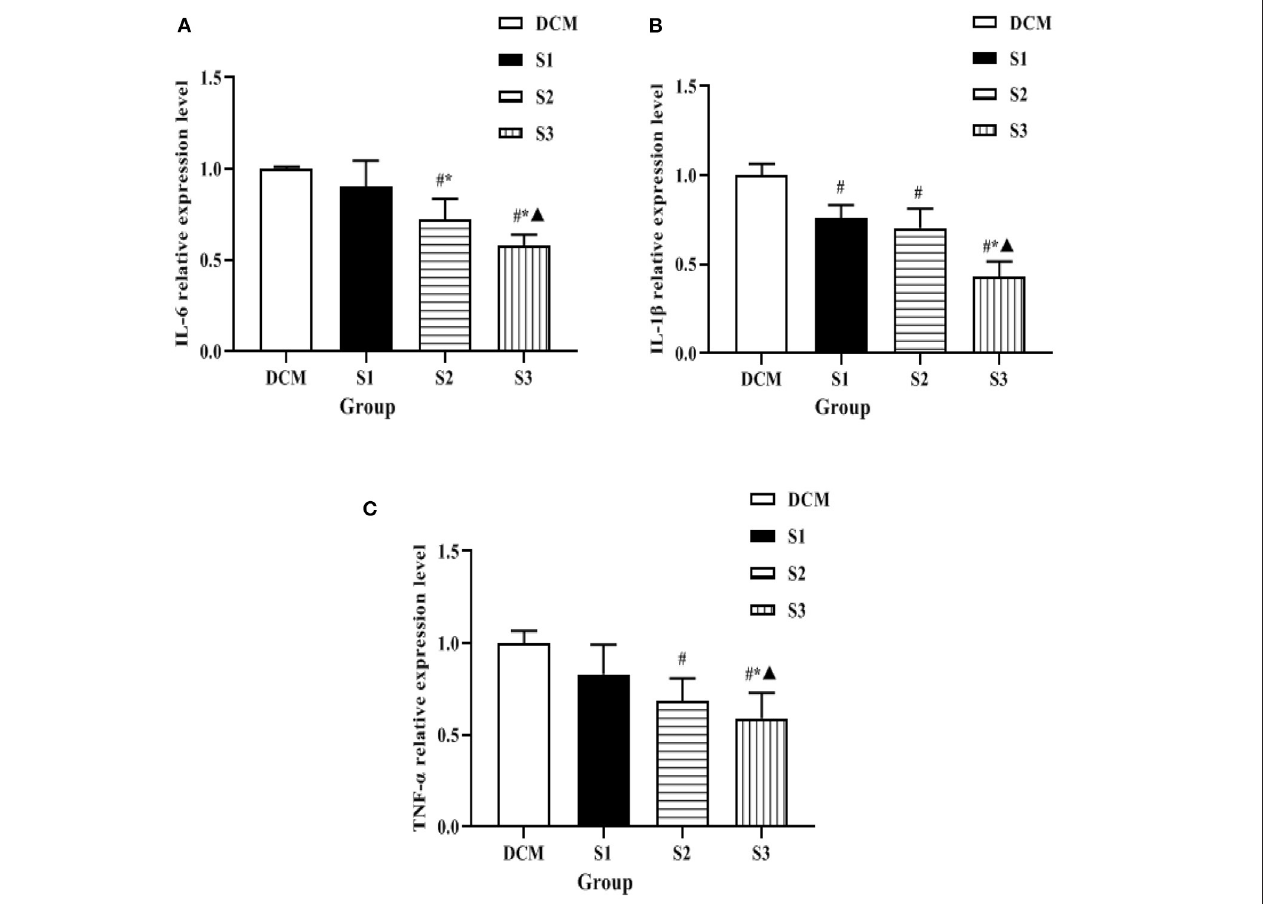
FIGURE 6 | Expression levels of inflammatory factors in myocardial tissue of rats in each group. (A) is the comparison of IL-6 expression levels among the four groups, (B) is the comparison of IL-1 β expression levels among the four groups, and (C) is the comparison of TNF- α expression levels among the four groups. Compared with the DCM group, # P < 0.05; compared with the S1 group, * P < 0.05; compared with the S2 group, N P <